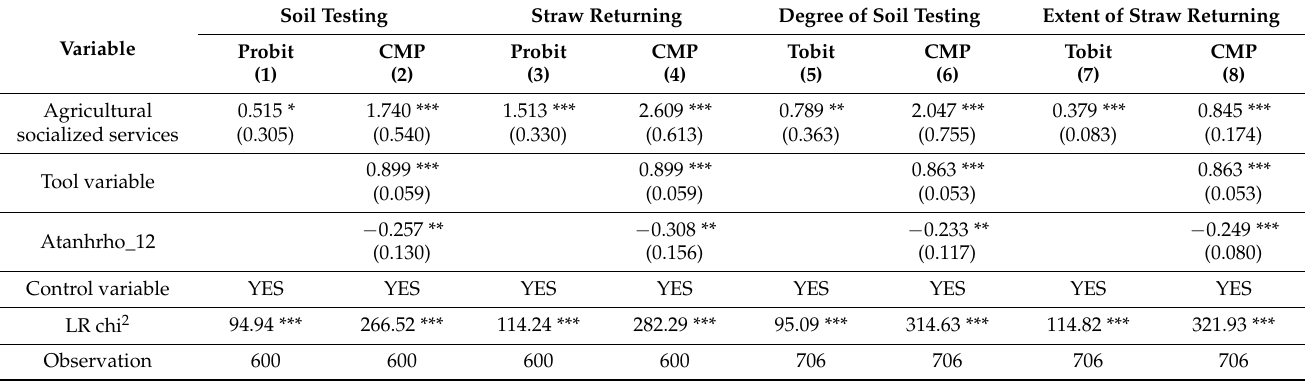
Table 3. Robustness